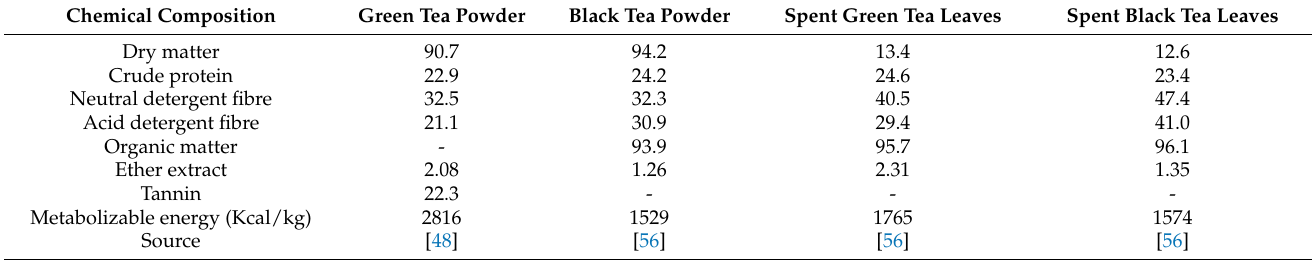
Table 1. Nutrient composition (%) of green and black tea leaf powders and their spent tea leaves.